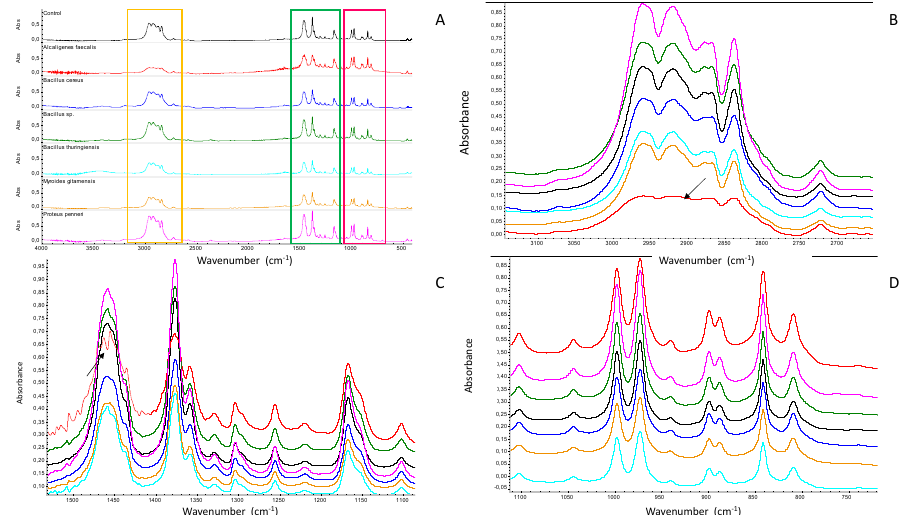
Figure 2. FTIR spectra of mechanically crushed spheres of polypropylene (PP). ( A ) spectra from polymers without inoculum (control) and with each one being bacteria inoculated; ( B ) Detail of spectra in vibration band between 3100 and 2500 cm − 1 ; ( C ) Detail of spectra in vibration band be ‐ tween 1600 and 1000 cm − 1 ; ( D ) Detail of spectra in vibration band between 1100 and 750 cm − 1 . Red line corresponds to PP mechanically crushed spheres inoculated with Alcaligenes faecalis , blue line with Bacillus cereus , green line with Bacillus sp., light blue line with Bacillus thuringiensis , orange line with Myroides gitamensis , pink line with Proteus penneri and black line corresponds to PP spheres without inoculum (control). Arrows are indicative of flattening peak (in B ) and triple peaks (in C ). Concerning polystyrene, although bacteria growth over polymer spheres was also visible and an increment in sphere weight was also determined (Table 3), no changes were observed in FTIR spectra (Figures 3 and 4). Results seem to suggest that the type of polymer, alongside metabolic adaptation of bacteria (i.e., polysaccharide production; [47,48]), may affect bacteria growth and their polymer attachment. In addition to chemical properties of plastic polymer spheres, differ ‐